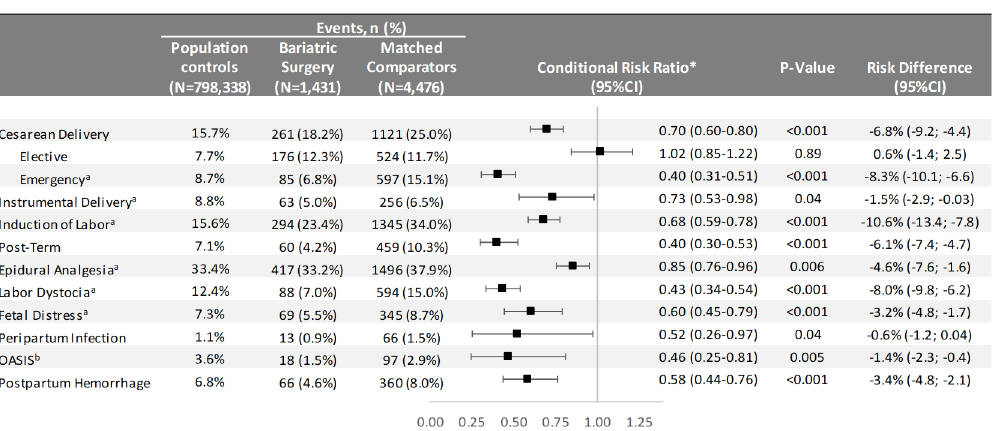
Fig 3. Delivery outcomes in singleton live term births in Sweden between 2006 and 2013. OASIS = obstetric anal sphincter injury (perineal tear grade III–IV). Emergency cesarean delivery = all unplanned cesarean sections. a Elective cesarean deliveries excluded. b Cesarean deliveries excluded. (cid:3) Conditioned on the matching factors maternal age, parity, pre-surgery BMI category (using early-pregnancy BMI in controls), early-pregnancy smoking status, educational level, height, country of birth, and delivery